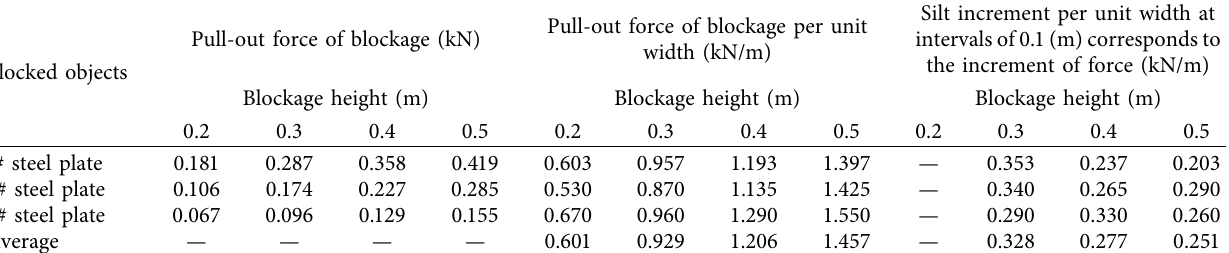
Table 10: Analysis of the influence of the height of underwater (mixed) silt.